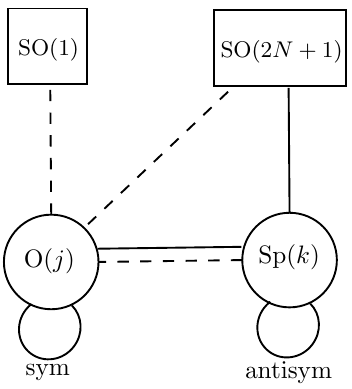
Figure 6 . The solid line represents a hypermultiplet while the dashed line represents a Fermi